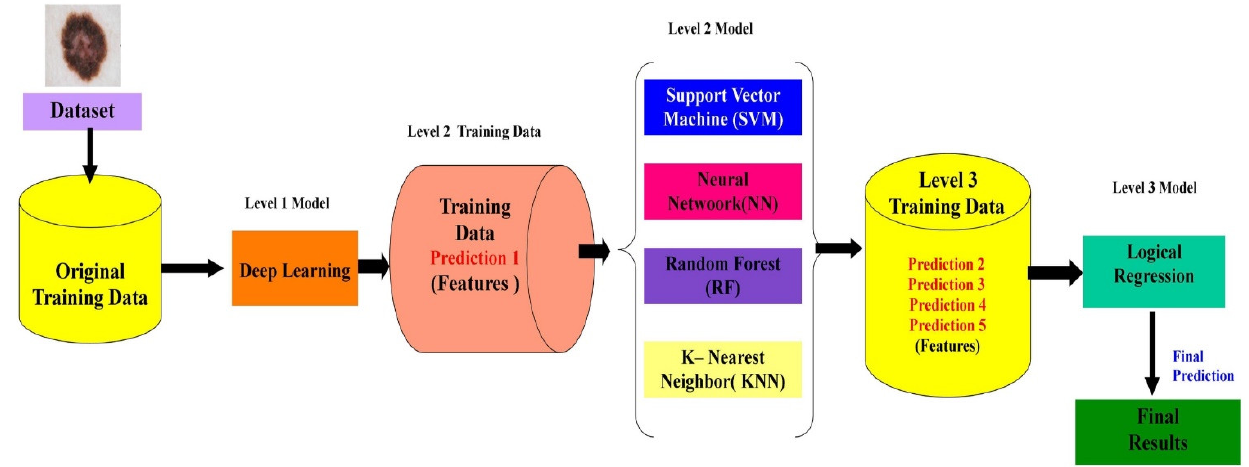
Figure 8. Proposed stacked CV based block diagram of the research.